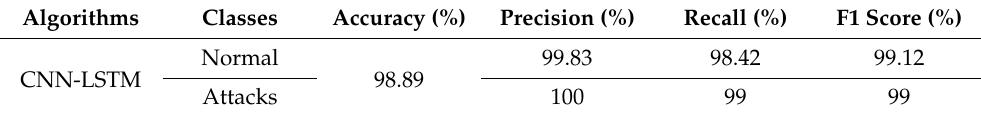
Table 7. Results of the DL CNN-LSTM model for detecting ICS attacks using binary classification. Algorithms